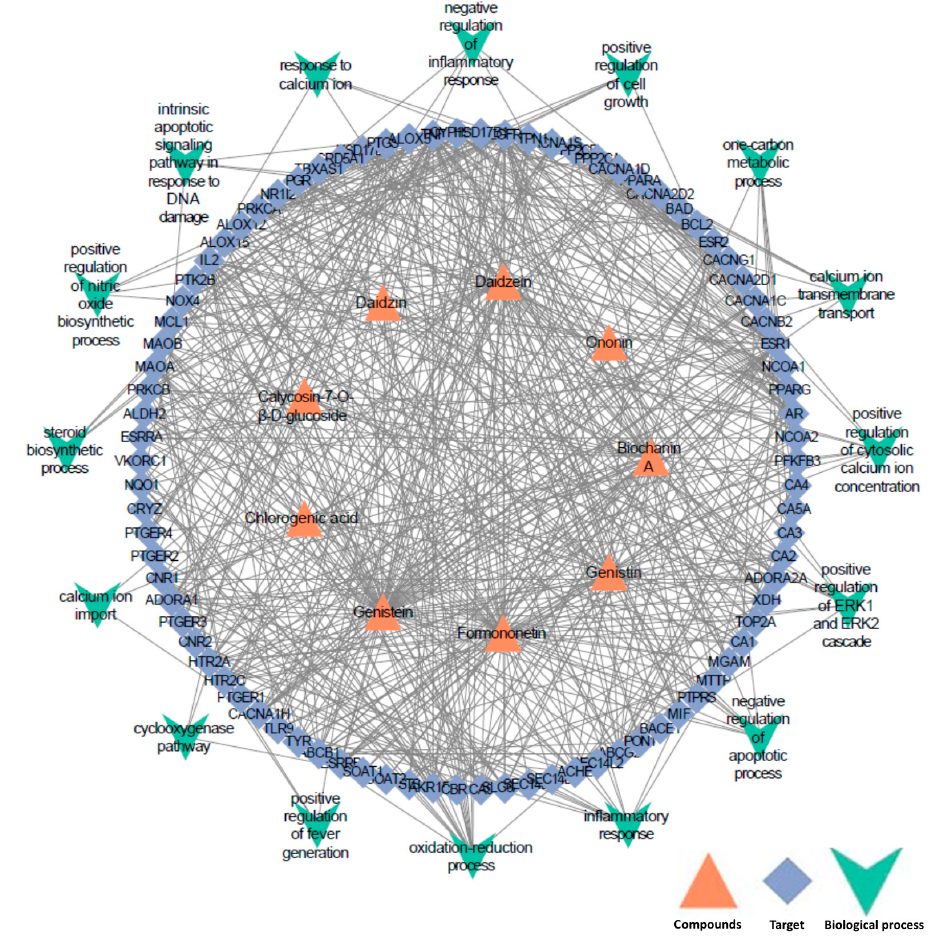
Figure 2. “Component-target-function” network for screening the quality control markers.